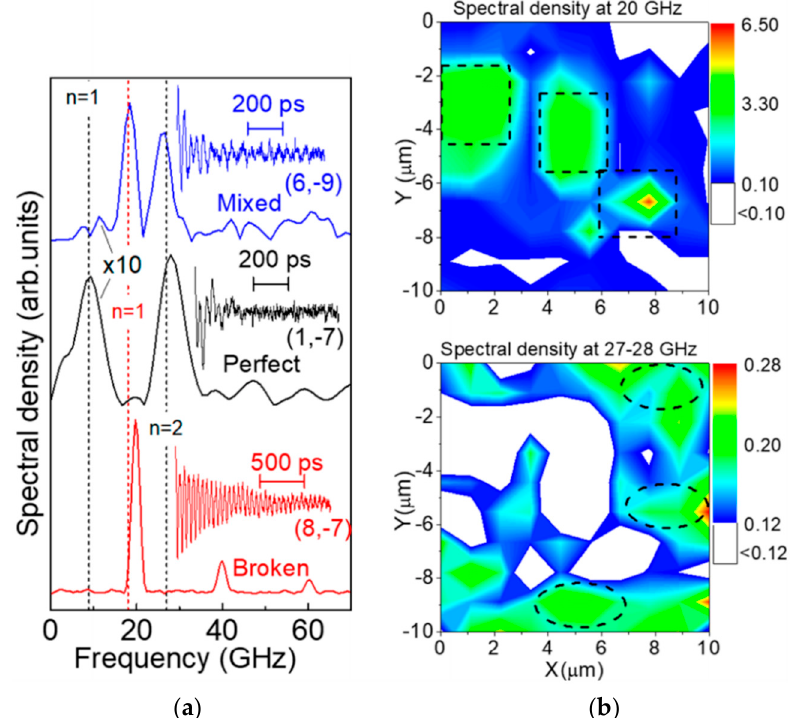
Figure 9. ( a ) Spectral density extracted from time-domain signals (shown as insets) measured on different areas of a 60-nm-thick InSe crystal. ( b ) Integrated spectral density over frequency ranges corresponding to (top) bad contact to the substrate and a match to Equation (9) with j = 1 or (bottom) good contact and a match to Equation (8) with j = 2. Republished with permission from [136], Copyright © 2019, American Chemical Society.